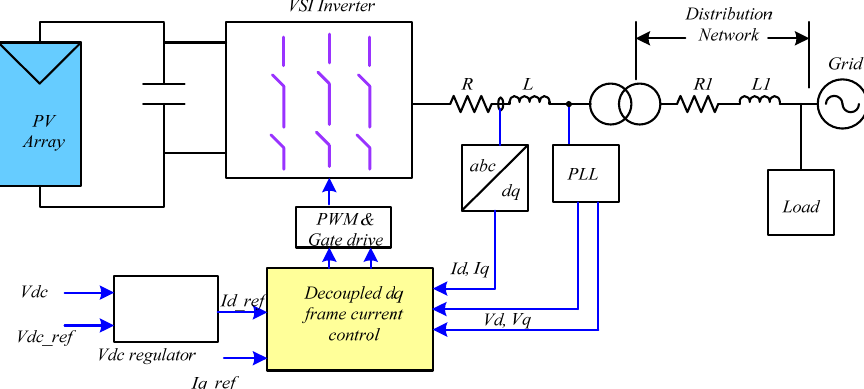
Figure 3. Schematic diagram of voltage-controlled grid-connection inverter.